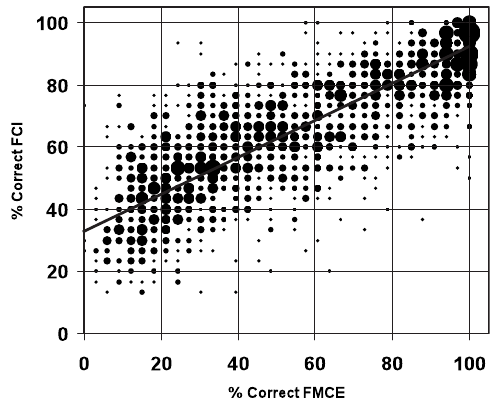
FIG. 2. A bubble plot of Postinstruction % correct on the FCI vs % correct on the FMCE. There are 1702 students in this group. The slope of the best fit line through the data is 0.52 and the y intercept is 36. The correlation coefficient is 0.78. One student had a score of 20% on the FCI and 3% on the FMCE. Twelve students had a score of 97% on the FCI and a score of 100% on the FMCE.